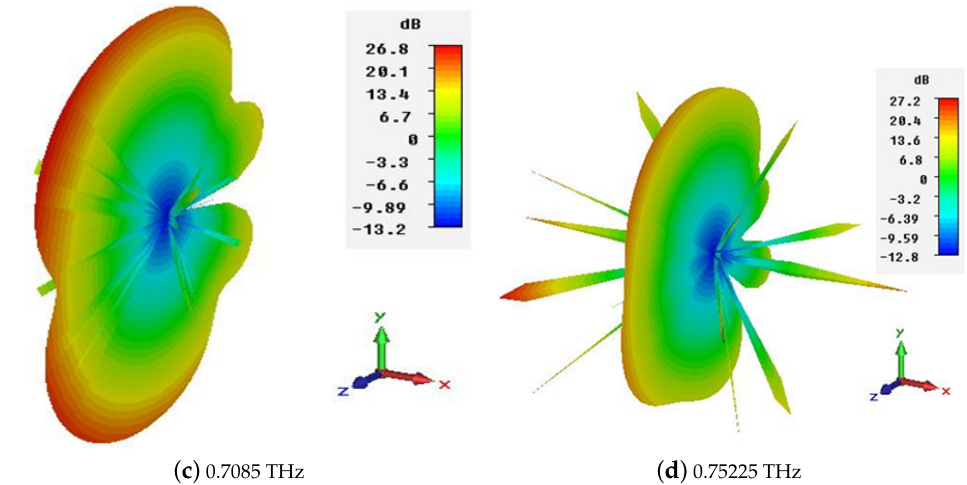
Figure 17. Comparison of 3D radiation pattern for dual-band Type D and E THz antenna array. ( a ) Type D antenna array at 0.7085 THz, ( b ) Type D antenna array at 0.75225 THz, ( c ) Type E antenna array at 0.7085 THz, and ( d ) Type E antenna array at 0.75225